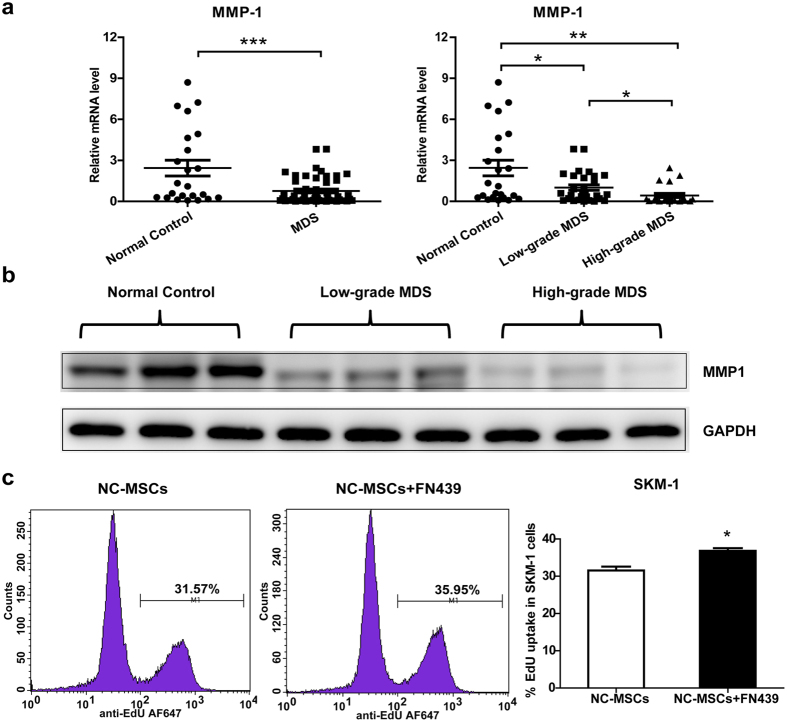
MMP1 is an inhibitory factor of MDS cell proliferation.(a) MMP1 mRNA expression in MDS-MSCs (n = 50; further classified as low-grade MDS (n = 29) and high-grade MDS (n = 21)) and normal control MSCs (n = 23) was measured by qPCR and compared with GAPDH. (b) MMP1 protein expression (54 kDa) in MDS-MSCs and normal control MSCs. (c)Addition of MMP1 inhibitor FN439 (5 μM) to normal control (NC) MSCs and SKM-1 co-culture increased the proportion of proliferating SKM-1 cells, as presented as flow cytometry plots (left) and a statistical figure (right). (Data represent the mean ± SEM from at least three independent experiments. *P < 0.05; **P < 0.01; ***P < 0.001).